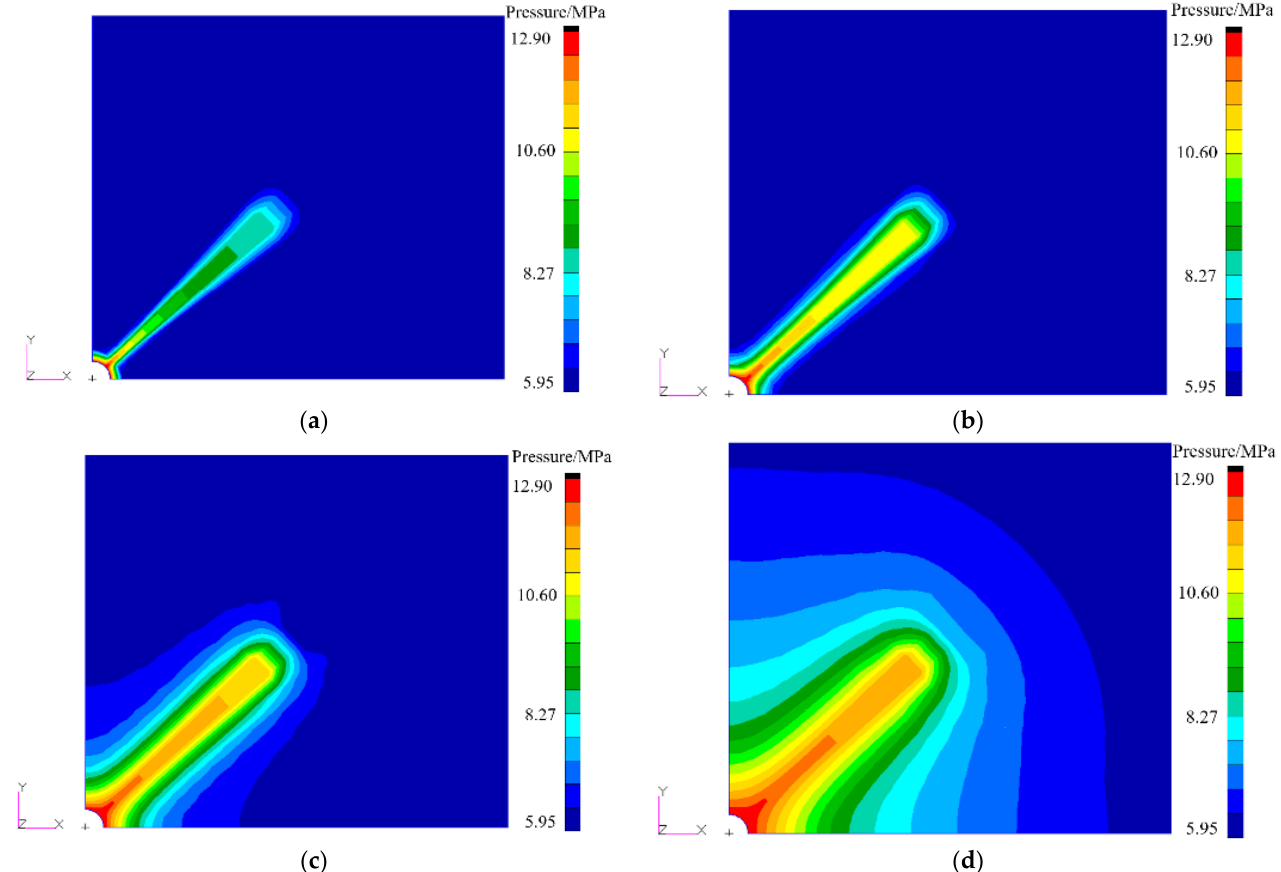
Figure 4. ( a – d ) Pressure propagation during water injection in the model when a fracture intersects the wellbore (top view), MPa.